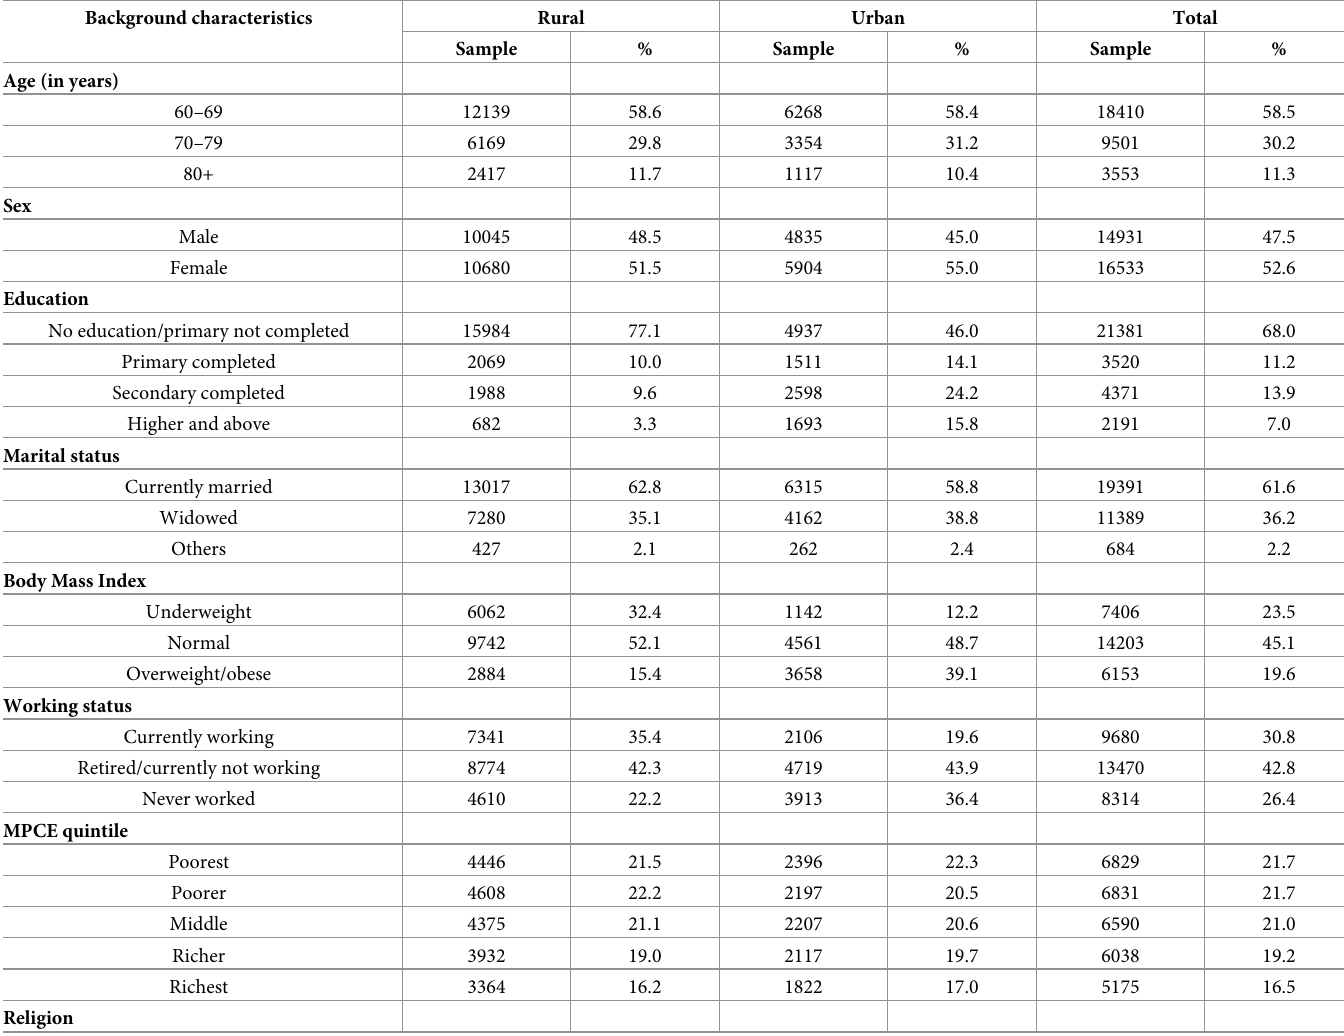
Table 1. Socio-demographic and economic profile of older adults in India,